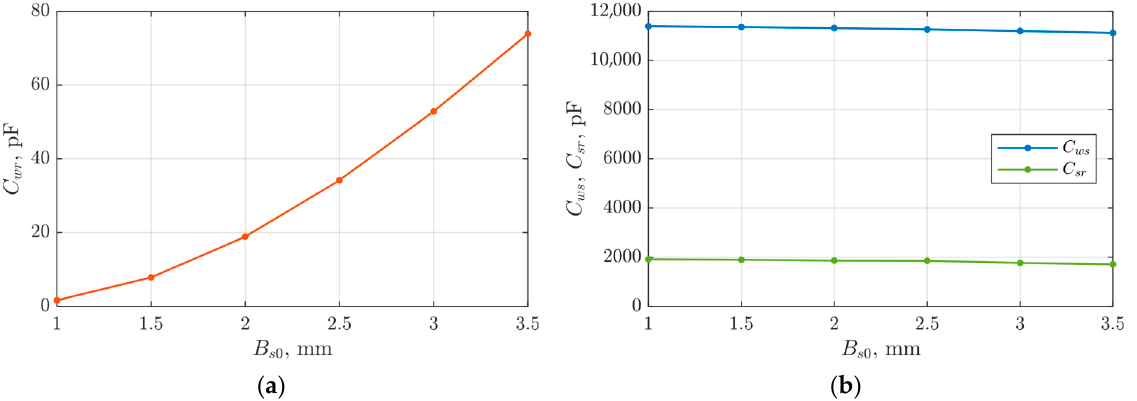
Figure 11. Characteristics of capacitance changes: ( a ) C wr , ( b ) C ws and C sr depending on the slot opening width B s0 .